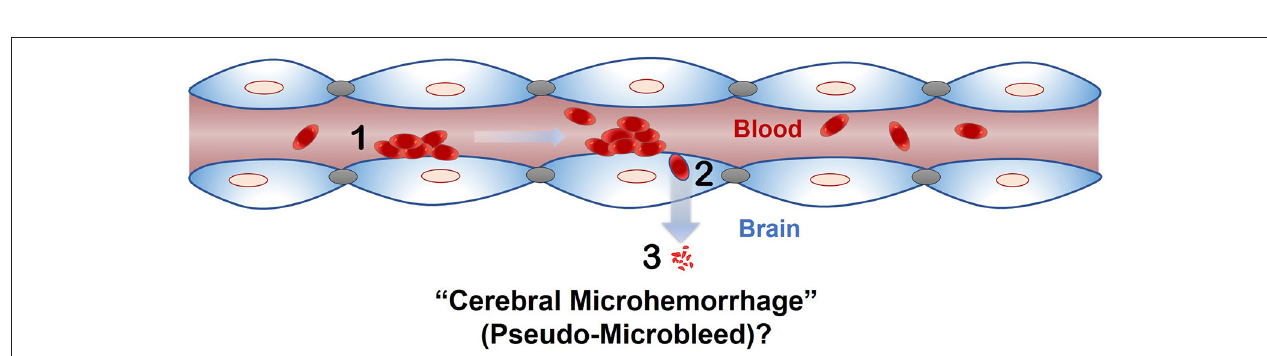
FIGURE 5 | Postmortem confocal microcopy images on mouse brains showing GFP-positive brain endothelium (green) and PKH-26-labeled RBC (red). ( A, Top): PBS-RBC remain in the blood vessels (white arrows heads). ( A, Bottom): t-BHP-treated RBC are inside (white arrow head) and outside the blood vessels (yellow arrow head), and also partially extravasated into the brain (blue arrow head). Orthogonal view showing PBS-treated RBC within the blood vessel ( B, Top) and t-BHP-treated RBC partially and completely outside the blood vessel ( B, Bottom). Scale bar = 50 µ m.